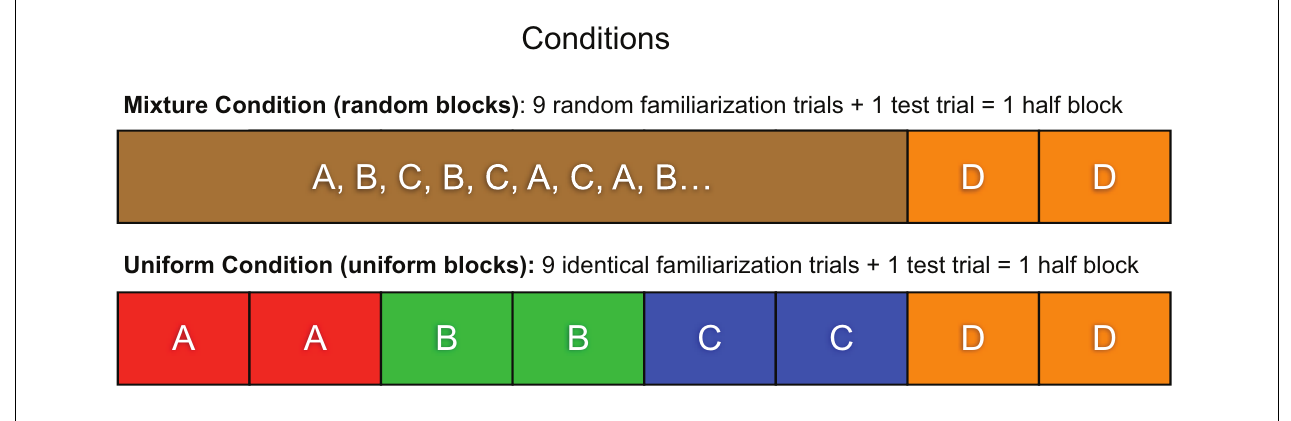
FIGURE 1 | Trial sequence of Mixture (random blocks) and Uniform (uniform blocks) conditions. An example of a sequence of ABC trials in the Mixture condition is presented in the figure. For all of the infants in the Mixture condition, these trials were presented in a random order (e.g., A, B, C, C, B, A or A, C, B, B, A, C, etc). Half blocks consisted of nine familiarization trials and one test trial. In the Uniform Condition (bottom panel), four blocks (eight half blocks) are depicted, where each block presented only A, B, C, or D events. In the Mixture Condition (top panel), four blocks are also depicted, where each of the first three blocks showed A, B, and C events, followed by a D-only